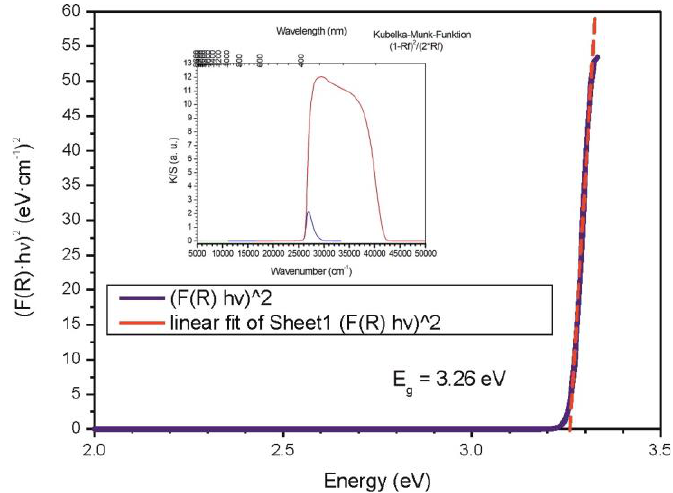
Figure 6. Tauc plots vs. photon energy E for direct band-gap (E g ) transition together with linear